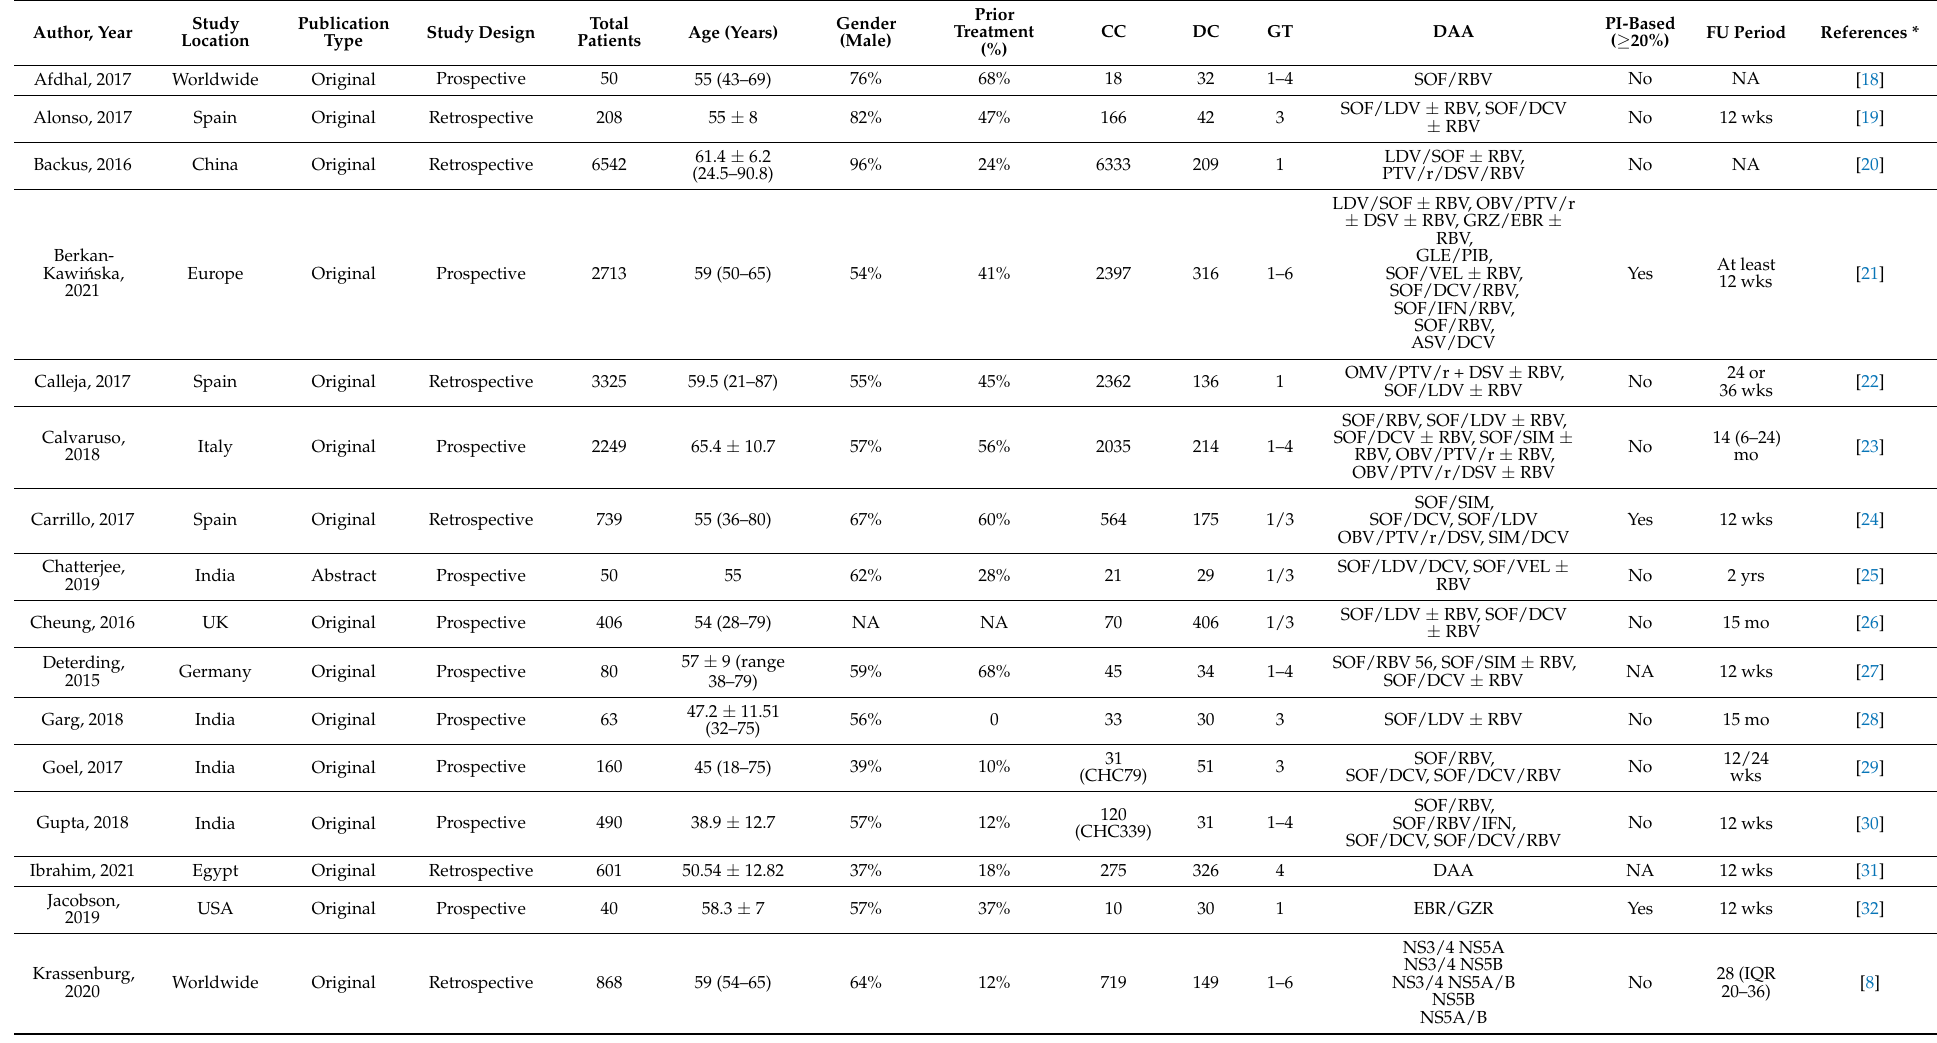
Table 1. General characteristics of included studies (n =